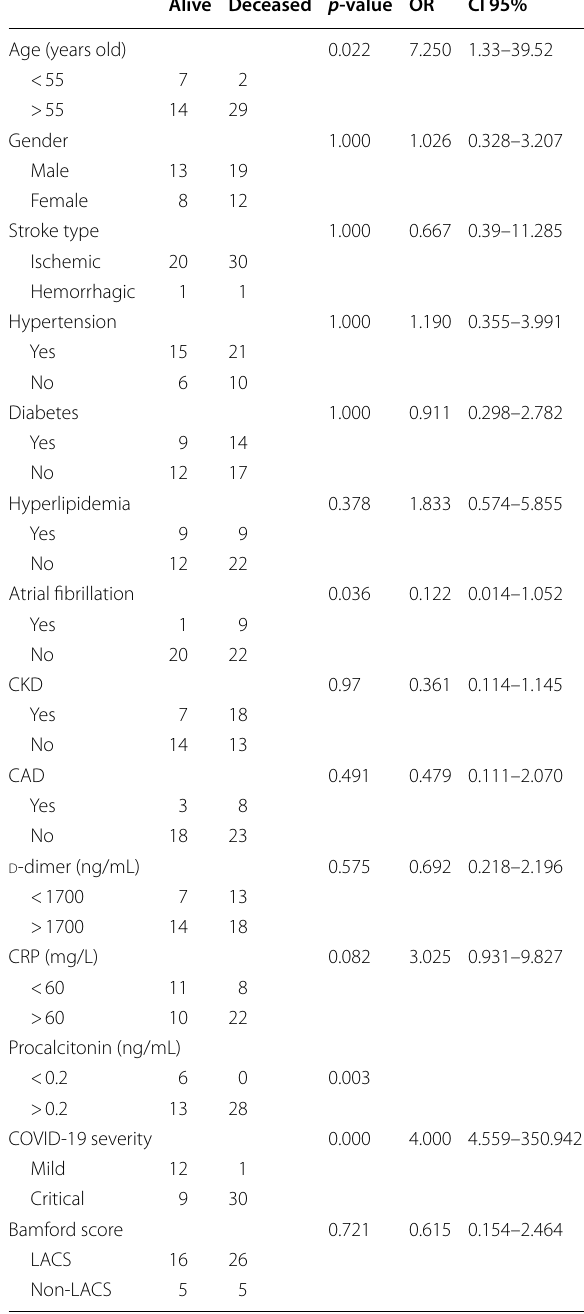
CKD chronic kidney disease, CAD coronary artery disease, CRP C-reactive protein, COVID-19 Coronavirus disease 2019, LACS lacunar